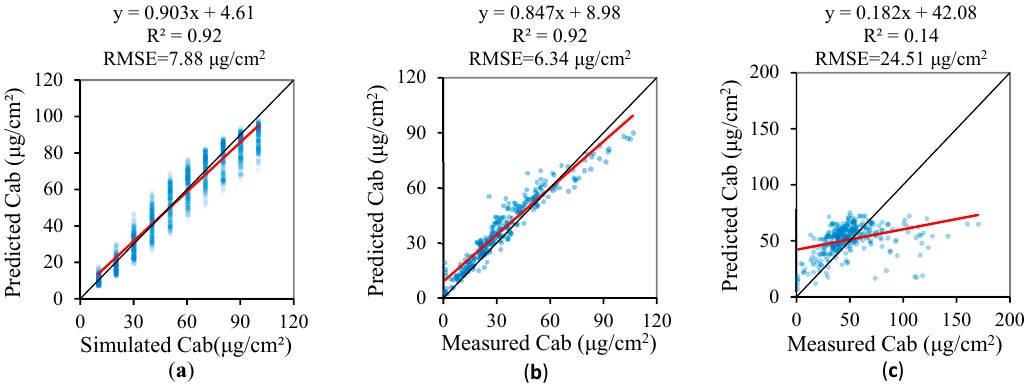
Figure 9. The results of the validation of the statistical model of the chlorophyll content (Cab) based on the PCA data-driven method obtained using the simulated ( a ), ANGERS ( b ) and LOPEX’93 datasets ( c ). RMSE is the root mean squared error computed the Cab model as in Equation (8); R 2 is the determination coefficient.